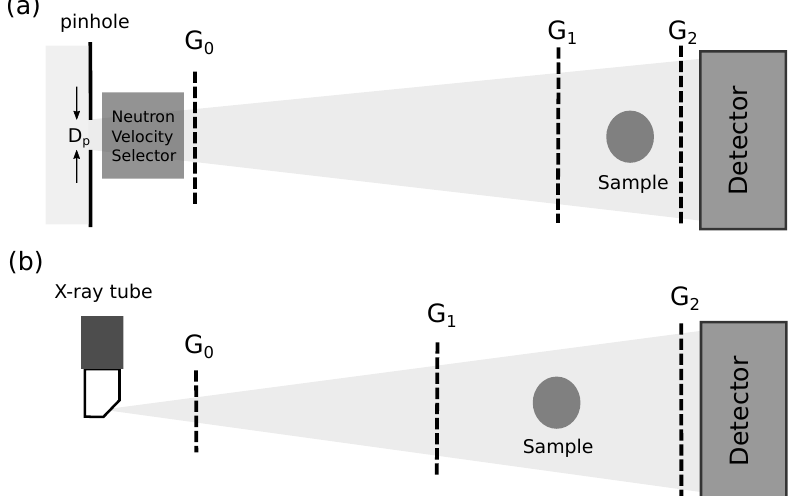
Figure 1. Schematic illustration (not to scale) of the neutron grating interferometer geometry ( a ) com- pared to the symmetric X-ray grating interferometer ( b